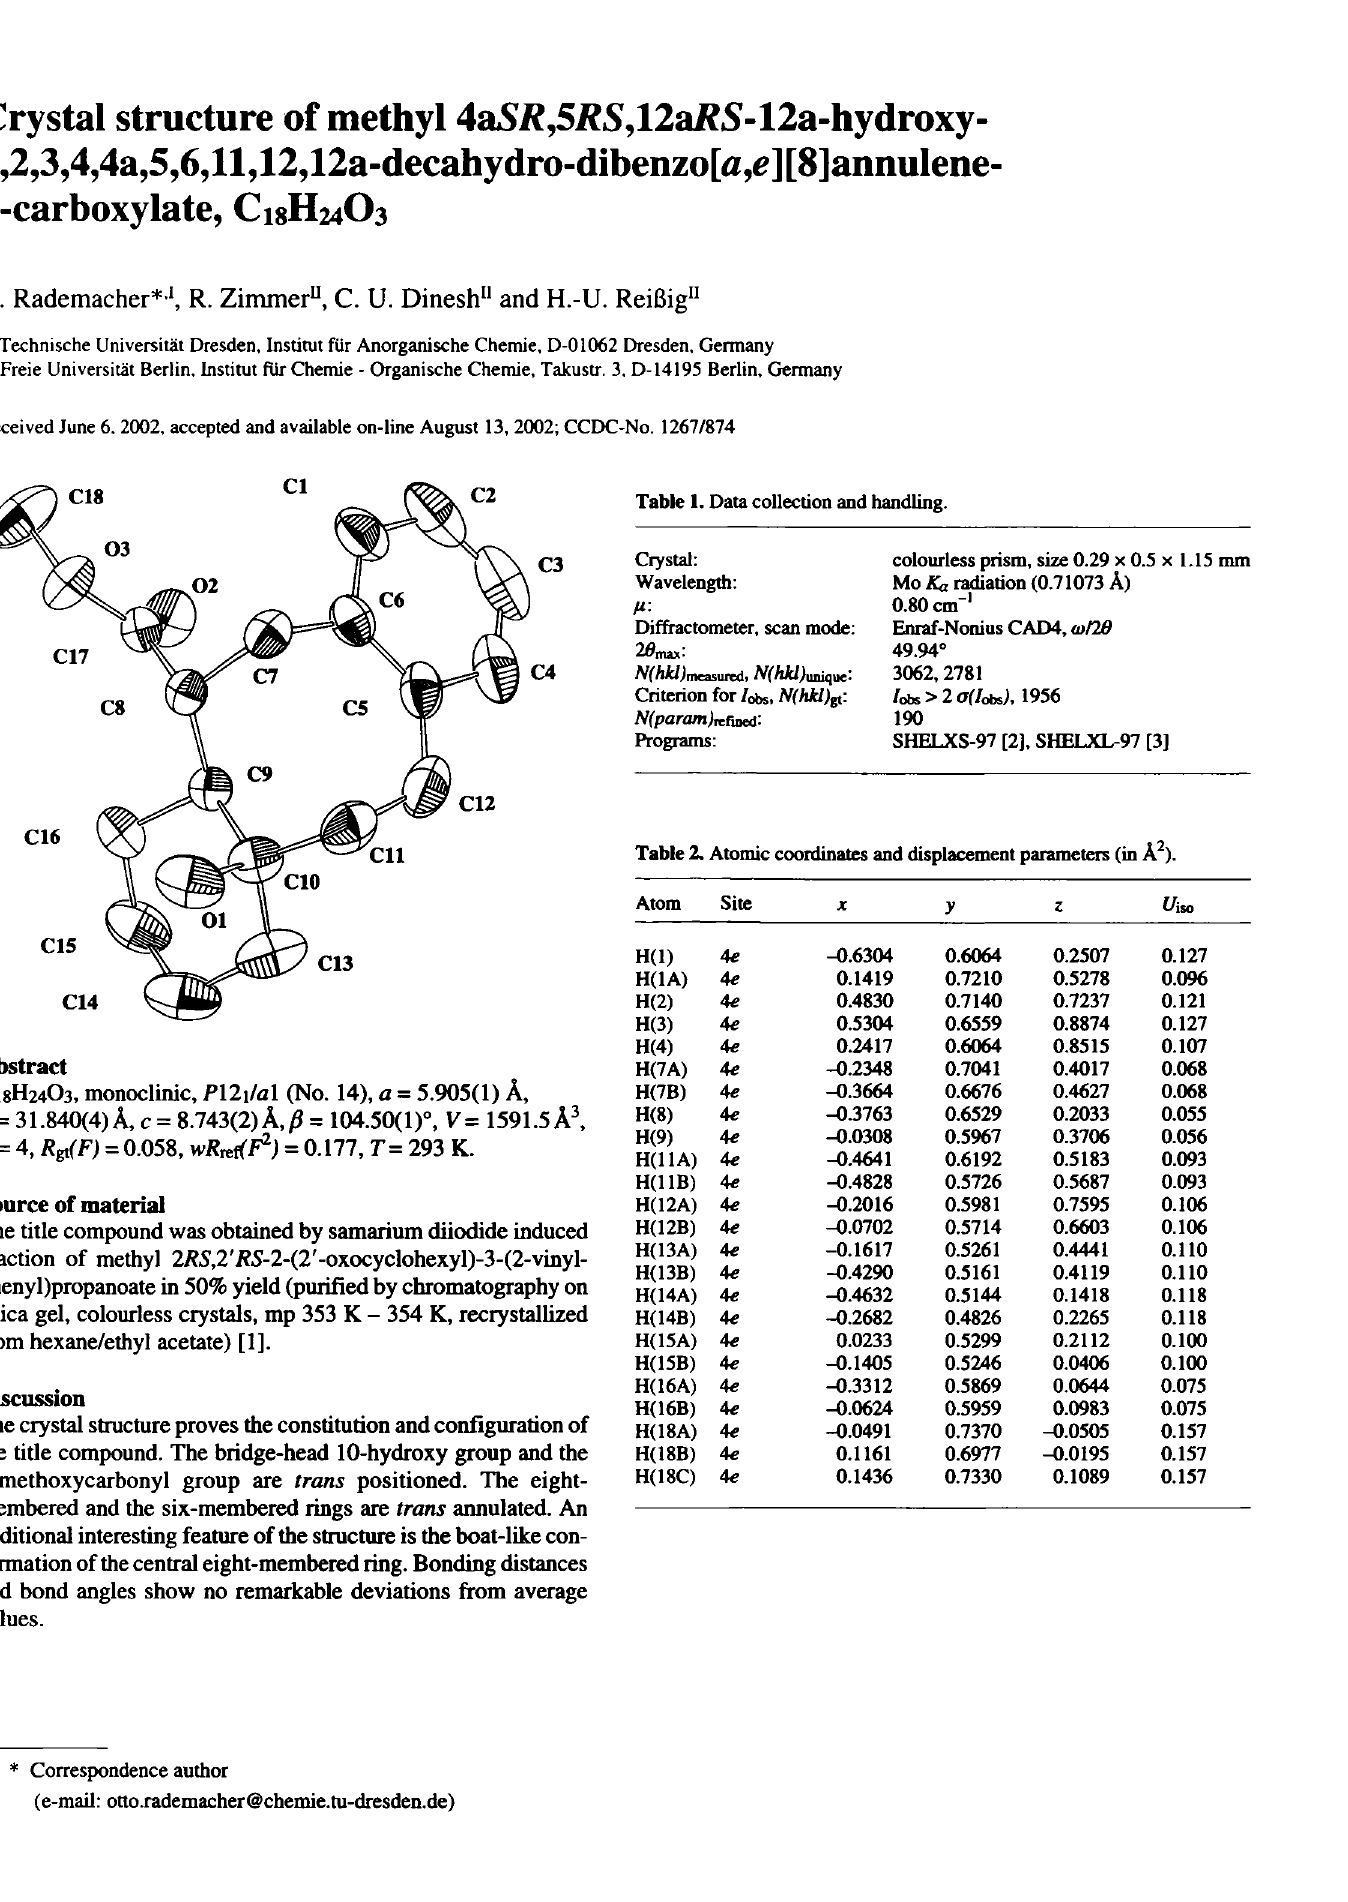
Table 1. Data collection and handling.